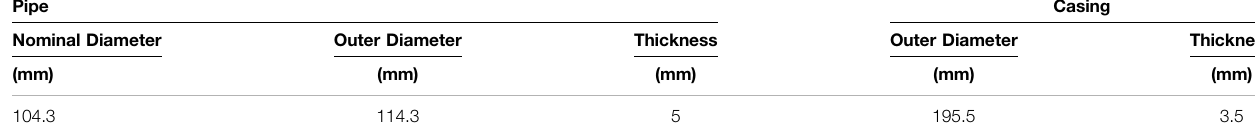
TABLE 1 | Dimensions of carrier and jacket pipes.